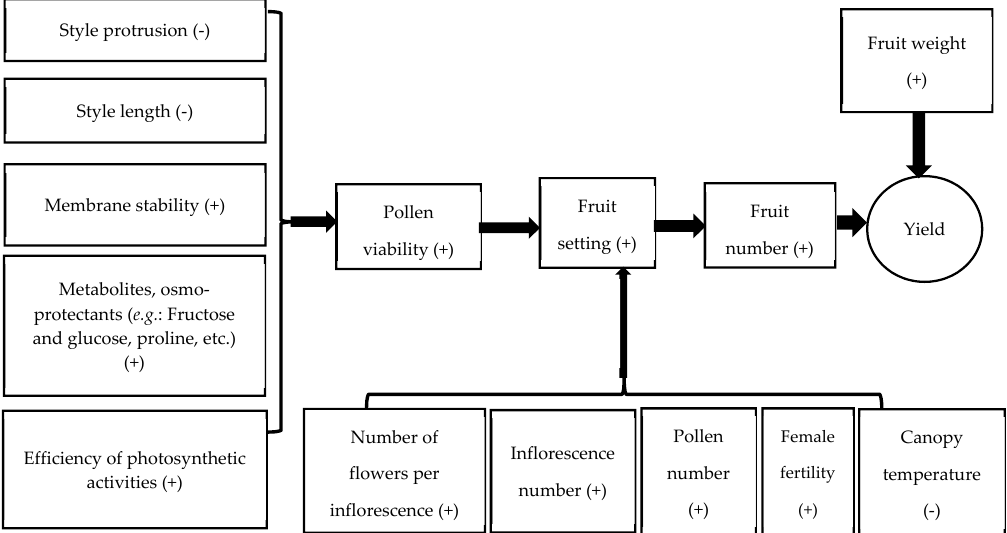
Figure 1. Key traits for improving heat tolerance in tomato. Legend: (-), Low manifestation of the phenotype or its absence is desired; and (+), High expression of the phenotype is desired. Membrane stability and simple sugars are positively correlated to pollen viability, which in its turn is positively correlated to fruit setting. In the various studies, traits including pollen number, inflorescence number, and number of flowers per inflorescence were not found to be always correlated to fruit setting but their improvement will increase fruit number.